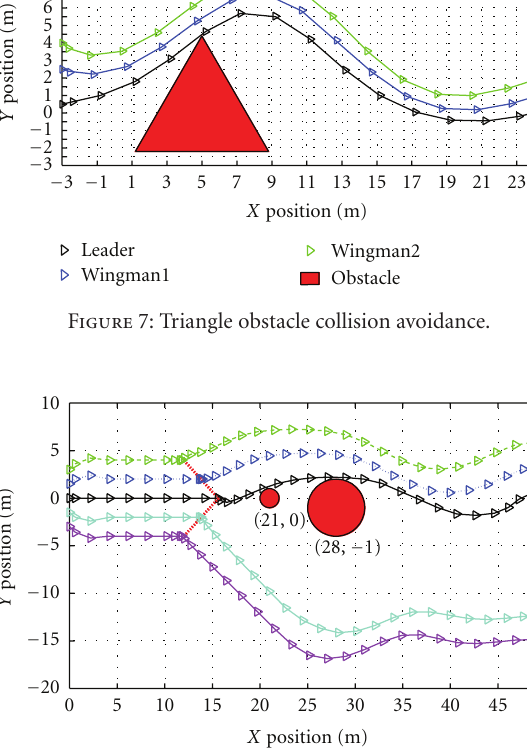
to the short predic-tive horizons. If the computational power is enough, better performance can be attained by setting the predictive horizon